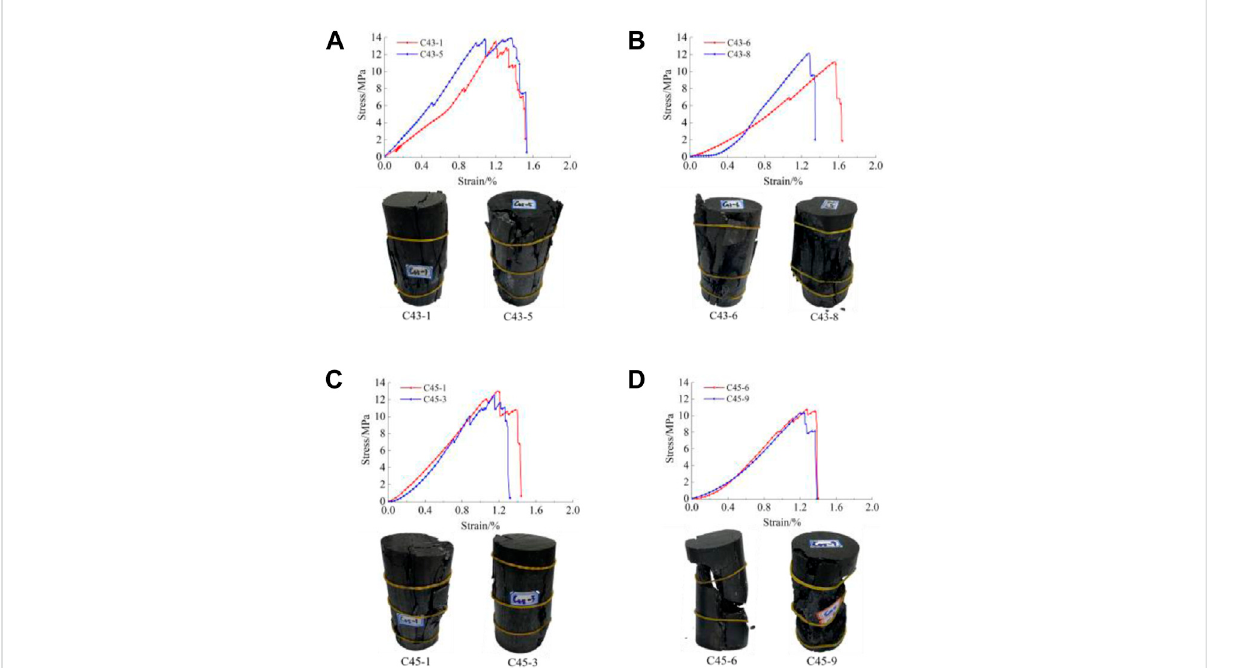
FIGURE 3 Typical uniaxial compression stress – strain curves and failure characteristics of 43# and 45# coal samples under natural and water saturation conditions. (A) Natural state of 43# coal samples. (B) Water-saturated state of 43# coal samples. (C) Natural state of 45# coal samples. (D) Water- saturated state of 45# coal